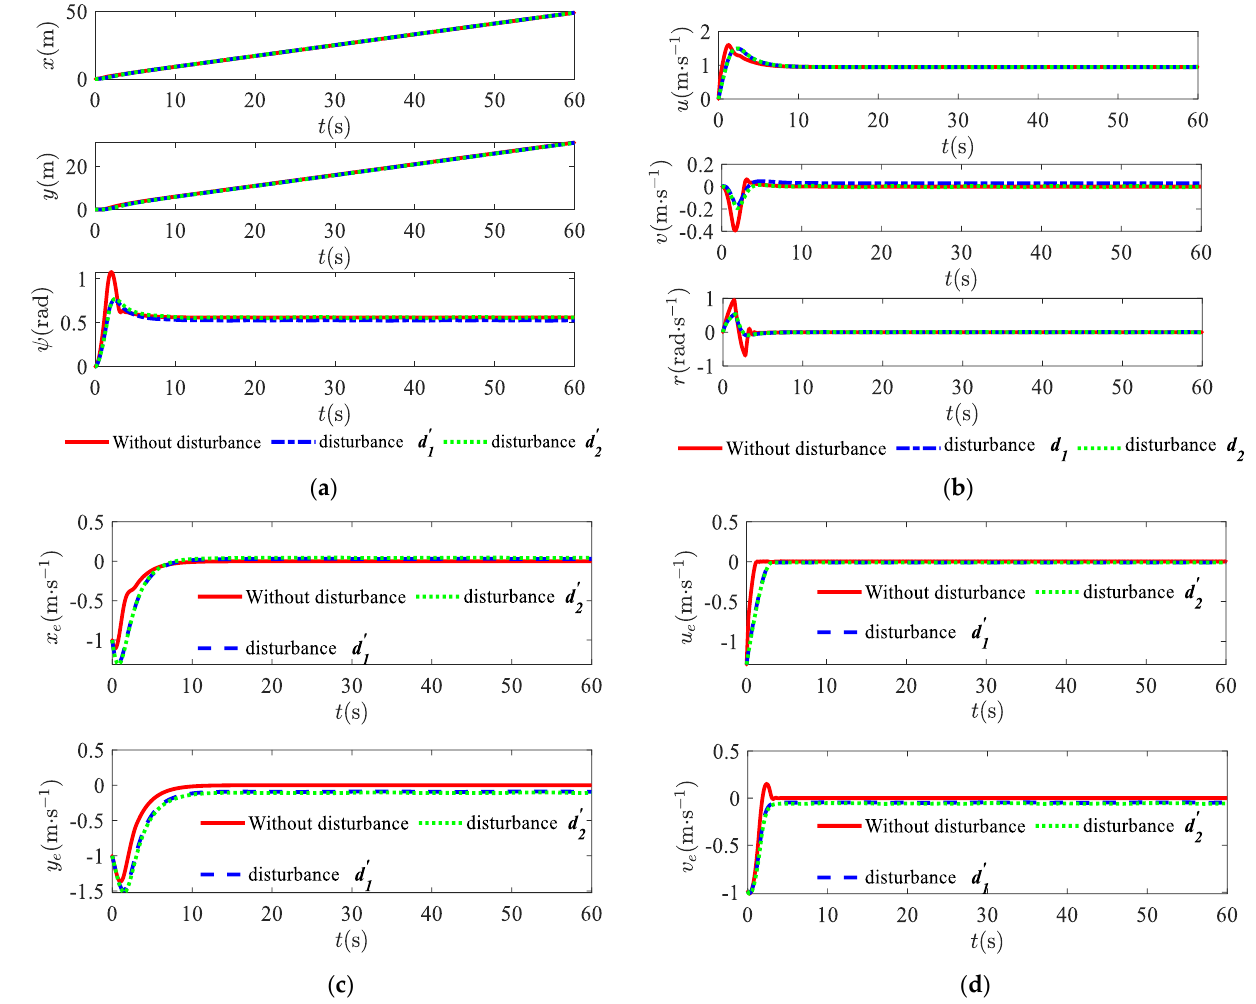
( d ) Figure 3. Disturbance observer simulation results: ( a ) actual values and observed values for con- stant disturbances; ( b ) actual values and observed values for time-varying disturbances; ( c ) con- stant disturbance errors; ( d ) time-varying disturbance errors. Figures 4a and 4b show the actual position variation curves and the actual velocity variation curves of the USV, respectively, in the three cases. As can be seen from the fig- ures, the position and speed curves under the effect of disturbances have the same pattern as those without disturbances, which further indicates that the controller has an excellent anti-disturbance capability. Figures 4c and 4d show the position error variation curve and velocity error variation curve of the USV, respectively, in the three cases. The position and